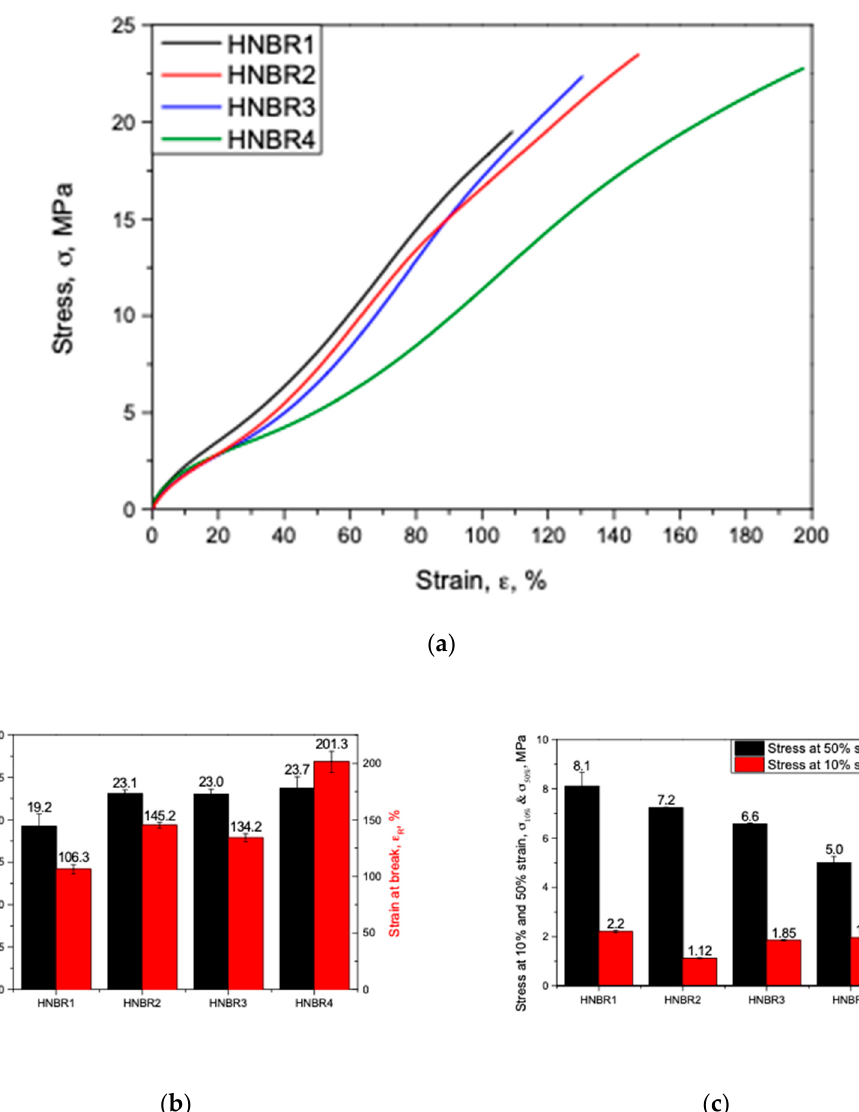
Figure 4. Tensile properties of CB-filled HNBR: ( a ) typical stress–strain curves; ( b ) tensile strength; ( c ) stress at 10% and 50% strain.